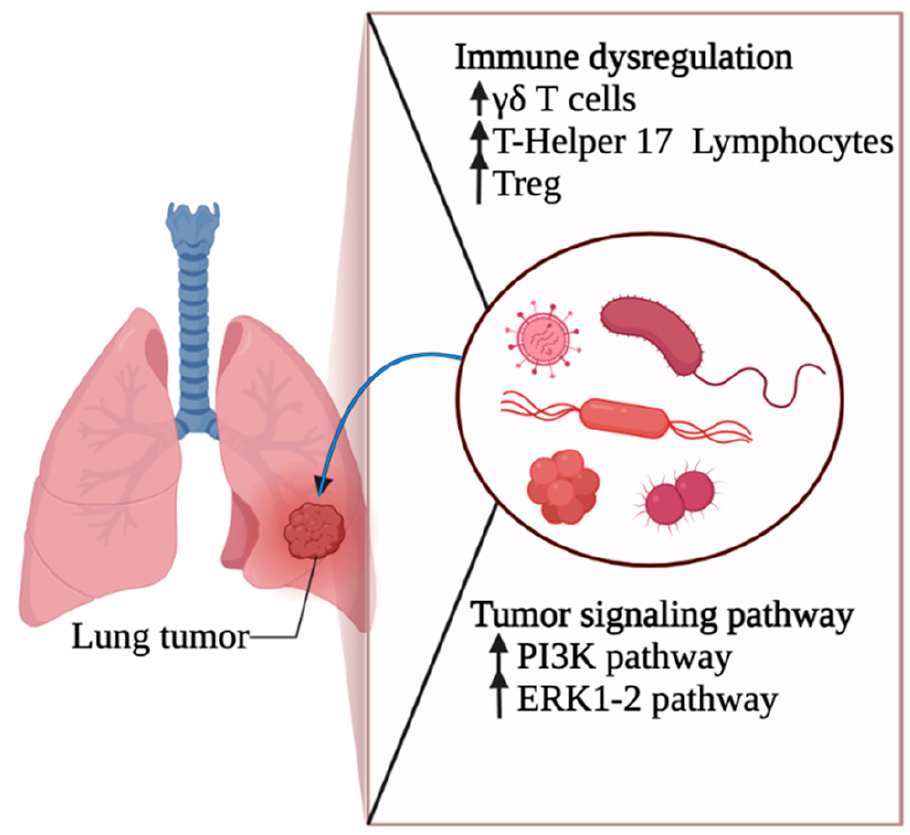
Figure 2. Lung Cancer and Microbiota. Local microbiota plays a critical role in the pathogenesis of lung cancer. Derived metabolites act as signaling molecules, directly amplifying tumor-intrinsic pathways. They can also induce immune dysregulation by favoring inflammation and immunosup- pression.